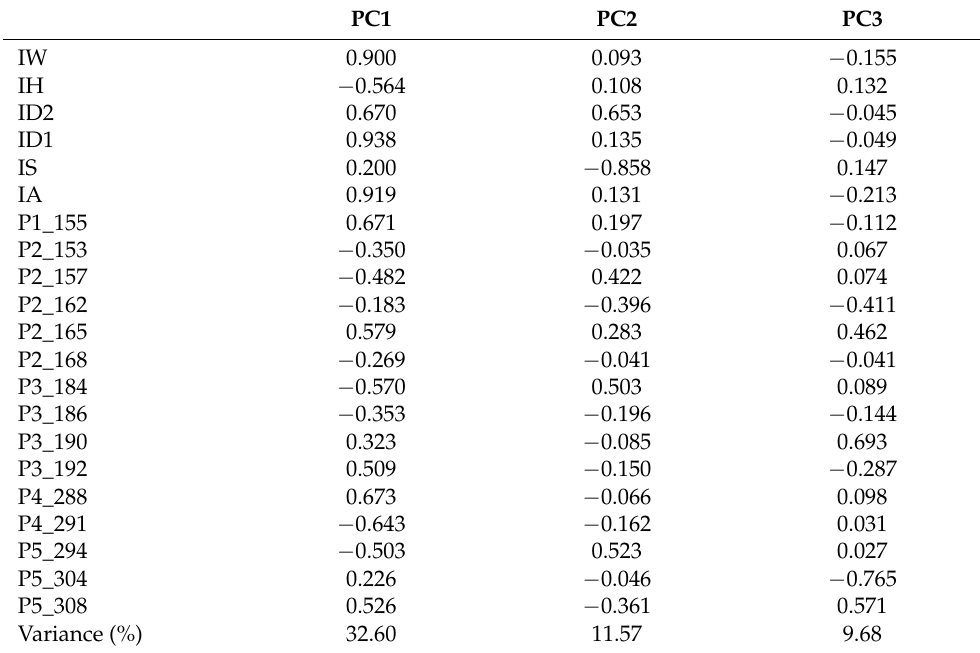
Table 4. Principal component of the rank of all the examined traits and for the most correlated allelic variants